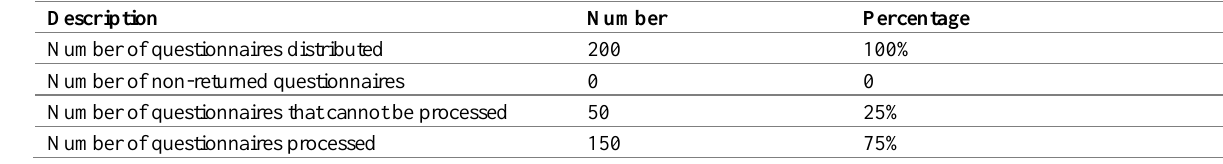
Table 3: Distribution and Return of Questionnaires